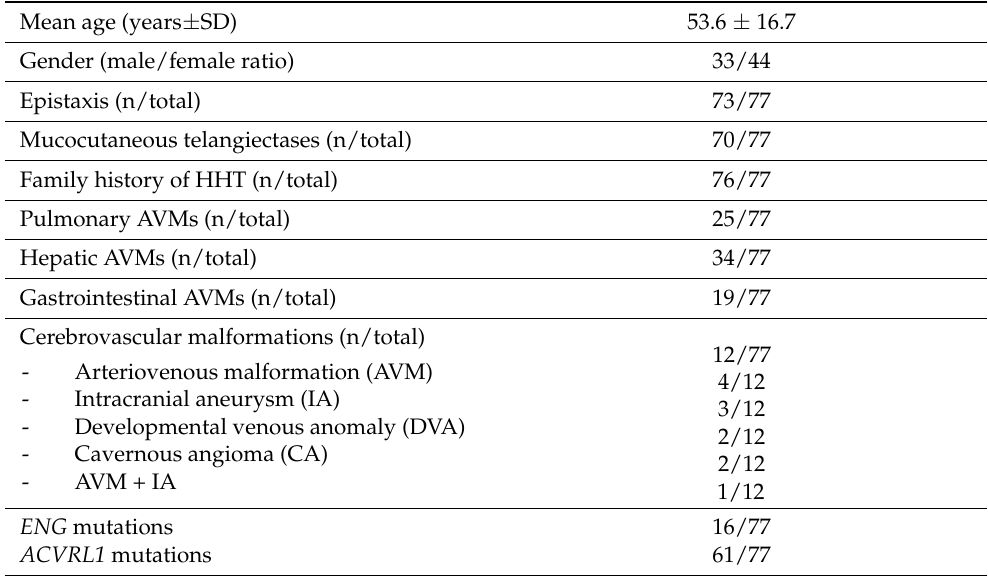
Table 1. Characteristics of the study population.